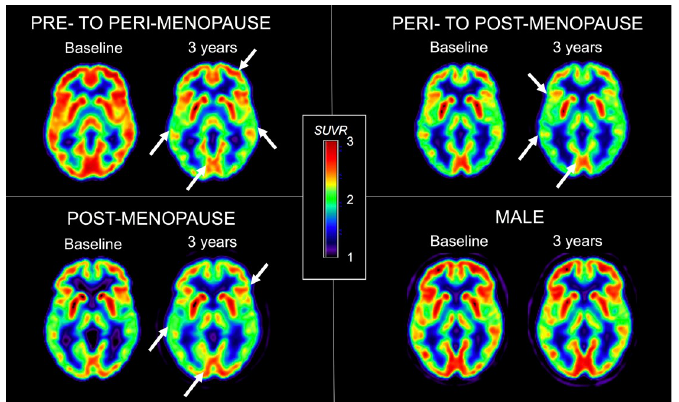
Fig 2. Baseline and follow-up FDG-PET scans in 4 representative cases. Top left: A 52 year-old woman (14 years education, APOE 3/4 carrier, CDR 0, MMSE 30) who was premenopausal at baseline and became perimenopausal by the follow-up exam. Top right: A 43 year-old woman (16 years education, APOE 3/3 carrier, CDR 0, MMSE 29) who was perimenopausal at baseline and became postmenopausal by the follow-up exam. Bottom left: A 59 year-old woman (16 years education, APOE 3/3 carrier, CDR 0, MMSE 30) who was postmenopausal at baseline. Bottom right: A 55 year-old man (14 years education, APOE 3/4 carrier, CDR 0, MMSE 30). Arrows point to areas of progressive CMRglc reductions in the follow-up vs. baseline scans. FDG measures are standardized uptake volume ratios (SUVR) adjusted for global uptake.